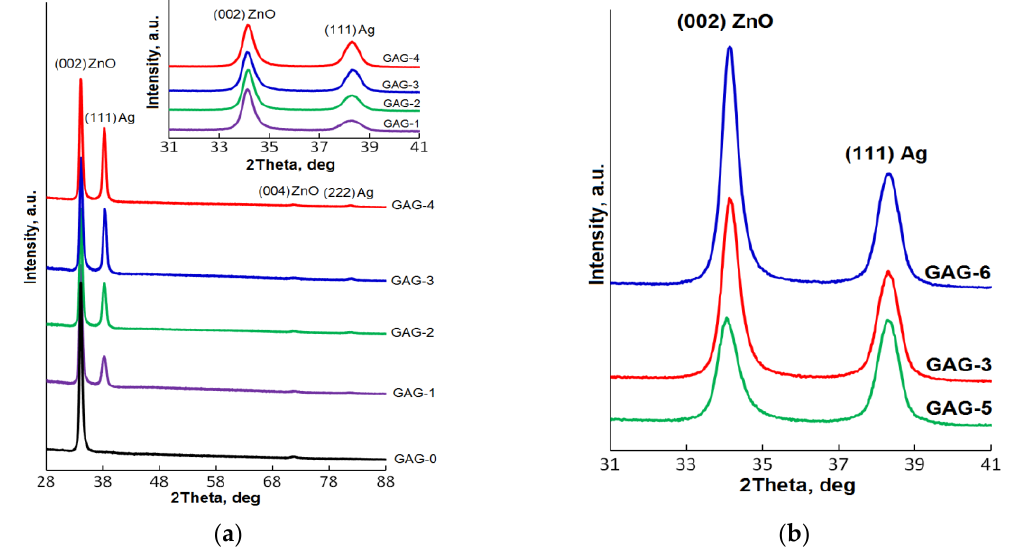
Figure 2. X-ray di ff raction (XRD) plots of the prepared multilayer structures: ( a ) with di ff erent Ag interlayer thicknesses; ( b ) with di ff erent thicknesses for bottom and top GZO layers. The inset Figure 2. X-ray diffraction (XRD) plots of the prepared multilayer structures: ( a ) with different Ag interlayer thicknesses; ( b ) with different thicknesses for bottom and top GZO layers. The inset of